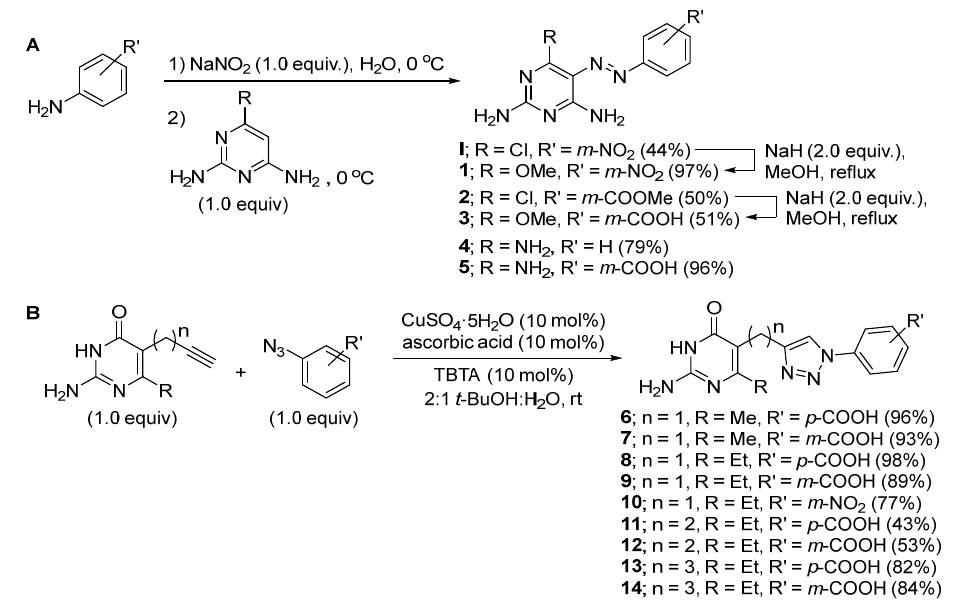
Figure 4. Synthesis of ( A ) 5-phenylazo-2,4-diamino pyrimidine derivatives (series 1); ( B ) phenyltriazolyl-2-amino-4-pyrimidinone analogs (series 2).